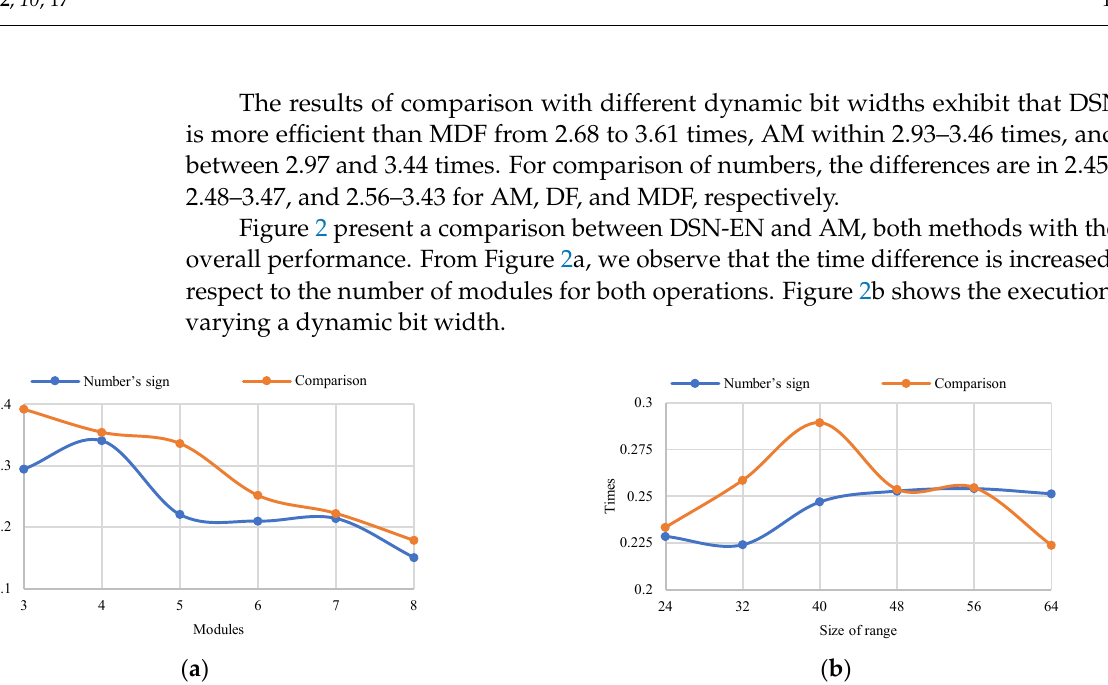
( d ) Comparison Figure 1. Performance of all methods to ( а ) determine the number’s sign with the dynamic number of modules (cid:1868) , ( b ) compare dynamic numbers of modules (cid:1868) , ( c ) determine the number’s sign with a dynamic bit width, and ( d ) compare numbers with a dynamic bit width. The results with a different number of modules (cid:1868) show: Considering the sign detec- tion with respect to DSN-EN, the efficiency of AM is between 1.93 and 5.64 times worst.